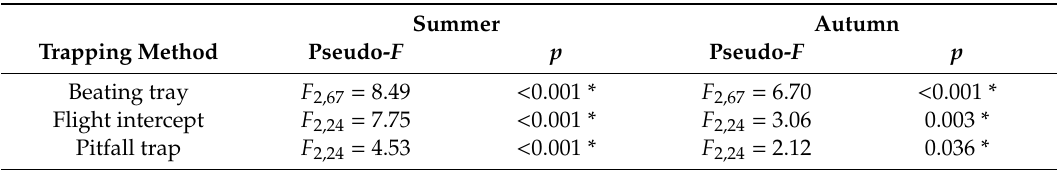
Table 3. Statistical results for di ff erences in community composition between treatments (broom present, heather present, and natives) after permutational analysis of variance (PERMANOVA), for three trapping